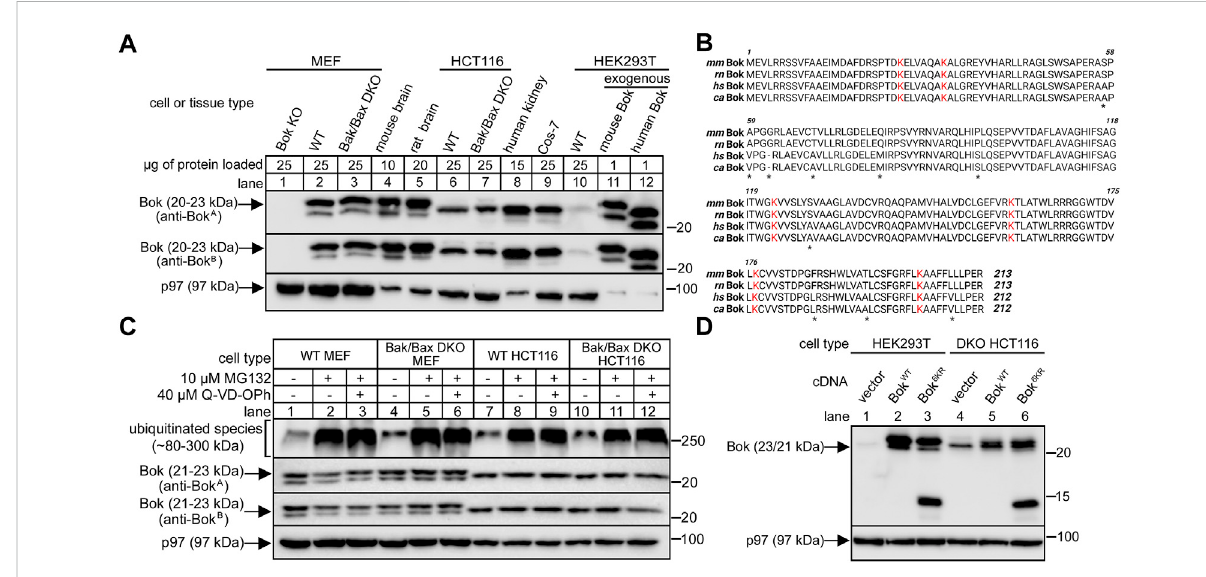
FIGURE 1 Bok expression in various cell lines and tissues and insensitivity to proteasome inhibition or lysine mutation. (A) , Endogenous Bok immunoreactivity inlysates from various cell lines and tissues, with p97 serving as aloading control. Anti-Bok A israised againstamino acids 19 – 32 of mouse Bok and anti-Bok B is raised against amino acids 1 – 150 of human Bok. Different amounts of protein were loaded to optimize visualization of immunoreactivity. Note that Bok migrates as a 23/21 kDa doublet in mouse and rat samples, and predominantly at 22 kDa in human samples. (B) , Amino acid sequences of mouse (mm), rat (rn), human (hs) and monkey (cs) Bok (accession numbers O35425, Q792S6, Q9UMX3, and A0A0D9R0C9, respectively), with asterisks denoting sequence differences and with lysine residues highlighted in red. (C) , Endogenous Bok immunoreactivityinlysatesfromMEFandHCT116cellsincubatedwithoutorwith10 μ MMG132and40 μ MQ-VD-OPhfor8 h,withp97servingasa loading control and ubiquitinated species serving as a positive control for MG132 effectiveness. (D), Effect of lysine mutation on exogenous Bok expression. HEK or DKO HCT116 cells were transiently transfected to expressmouseBok WT or Bok 6KR , inwhich all six lysines are mutated to arginine, and cell lysates were probed as indicated with anti-Bok A , with p97 serving as a loading control. While Bok WT migrates at 23/21 kDa, Bok 6KR was partially fragmented, as indicated by the appearance of additional bands at 14 and 12